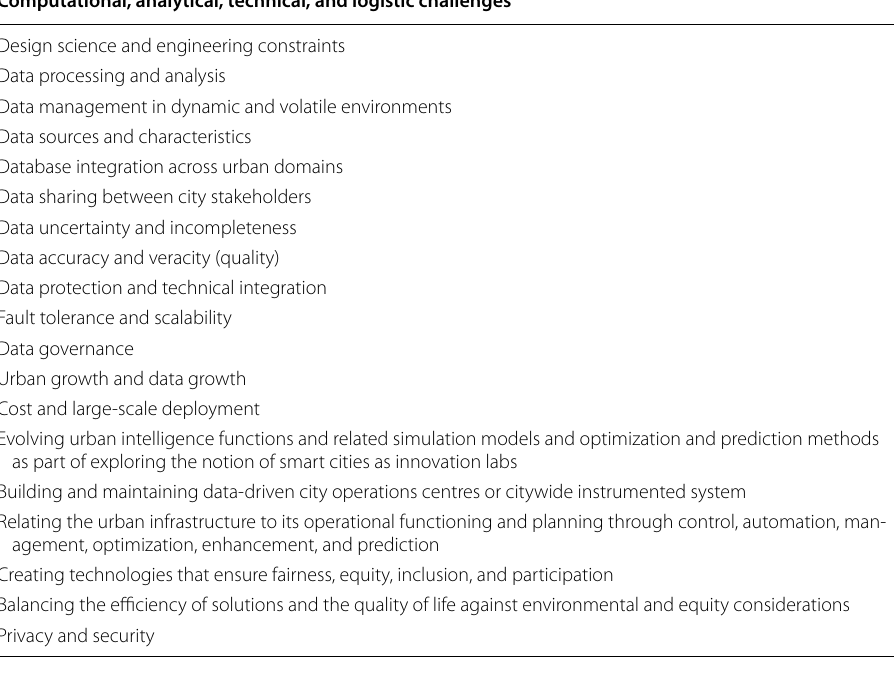
Table 2 Computational, analytical, technical, and logistic challenges. Source: Bibri [23] Computational, analytical, technical, and logistic challenges Design science and engineering